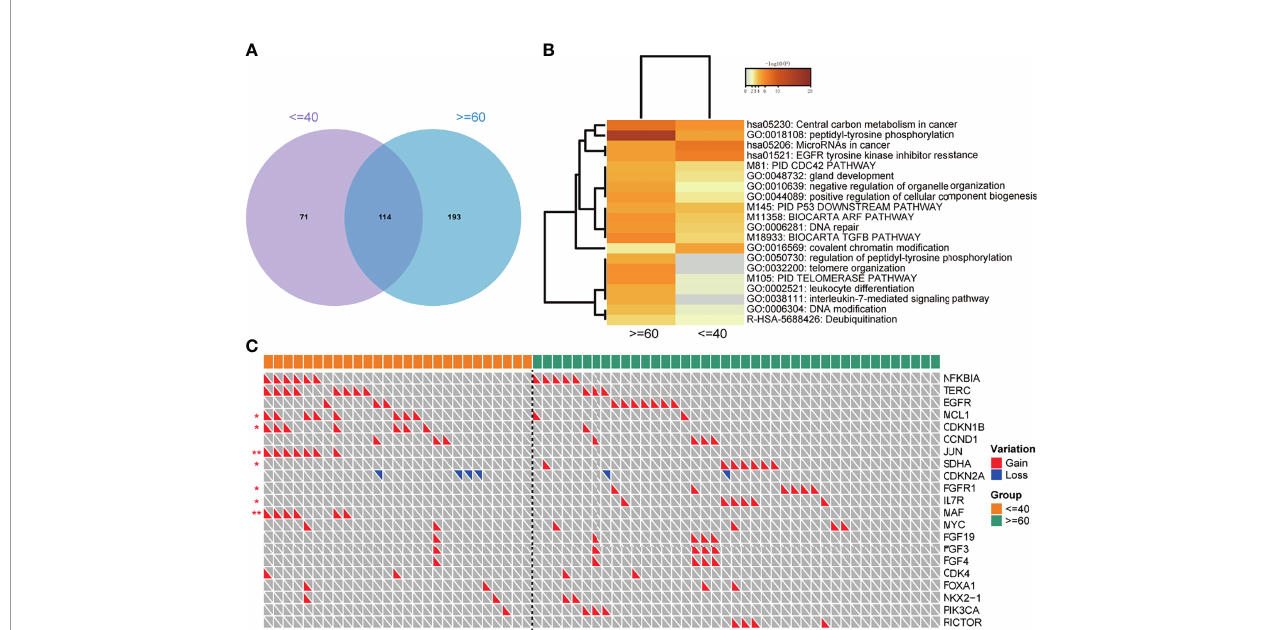
FIGURE 5 | Pathway analysis and the distribution of CNVs in the 165-sample cohort. (A) The number of overlapped mutations in the cohort. (B) Pathways that signi fi cantly enriched in two groups. (C) CNVs landscape of two groups. "*" means the p value < = 0.05; "**" means the p value < = 0.01.